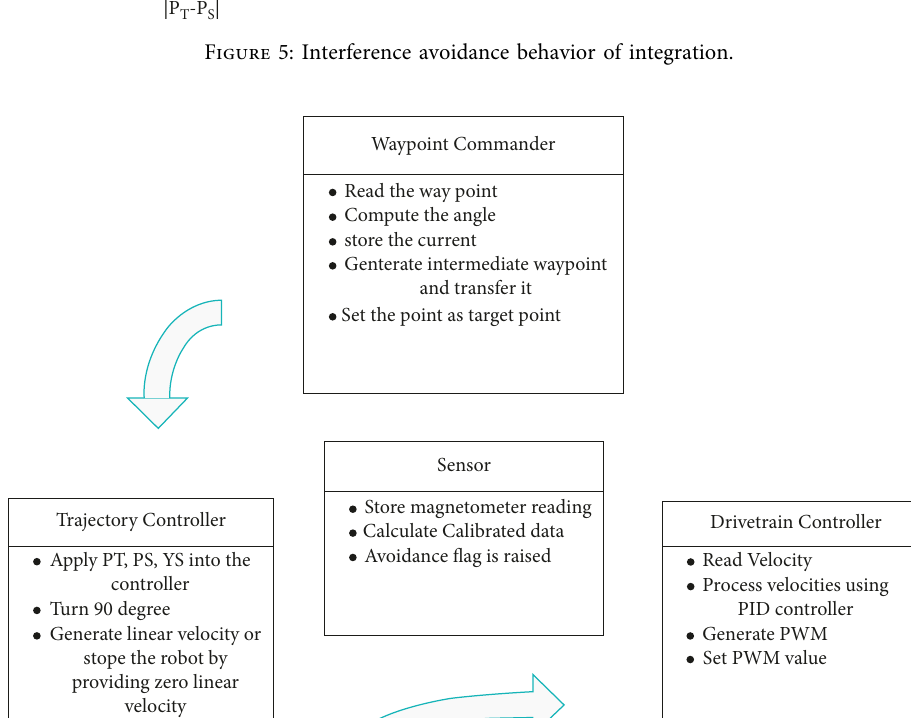
Figure 6: Representation of a detailed